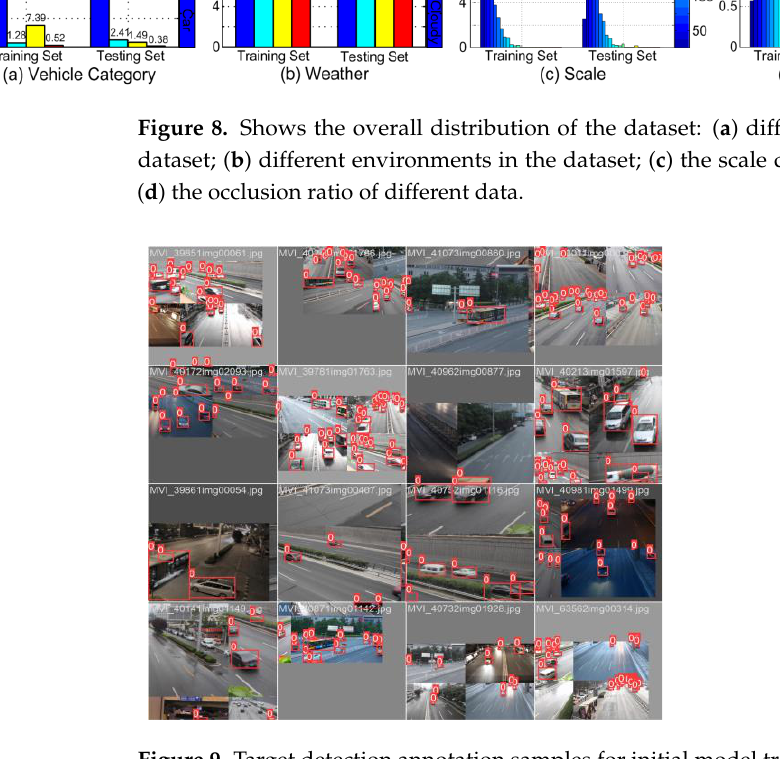
Figure 9. Target detection annotation samples for initial model training.